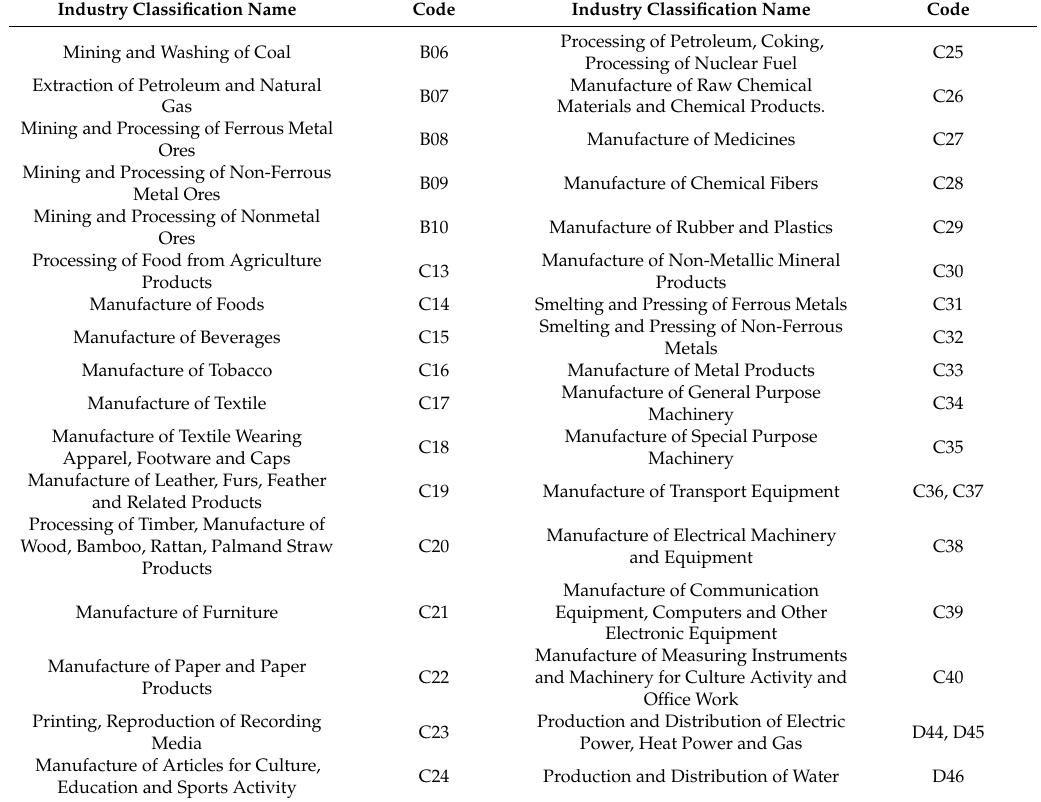
Table A1. List of sample